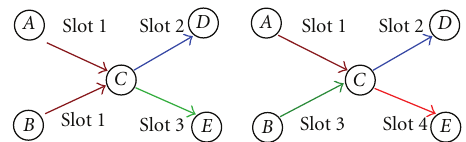
Figure 8: node-disjoint multipath is not optimal for